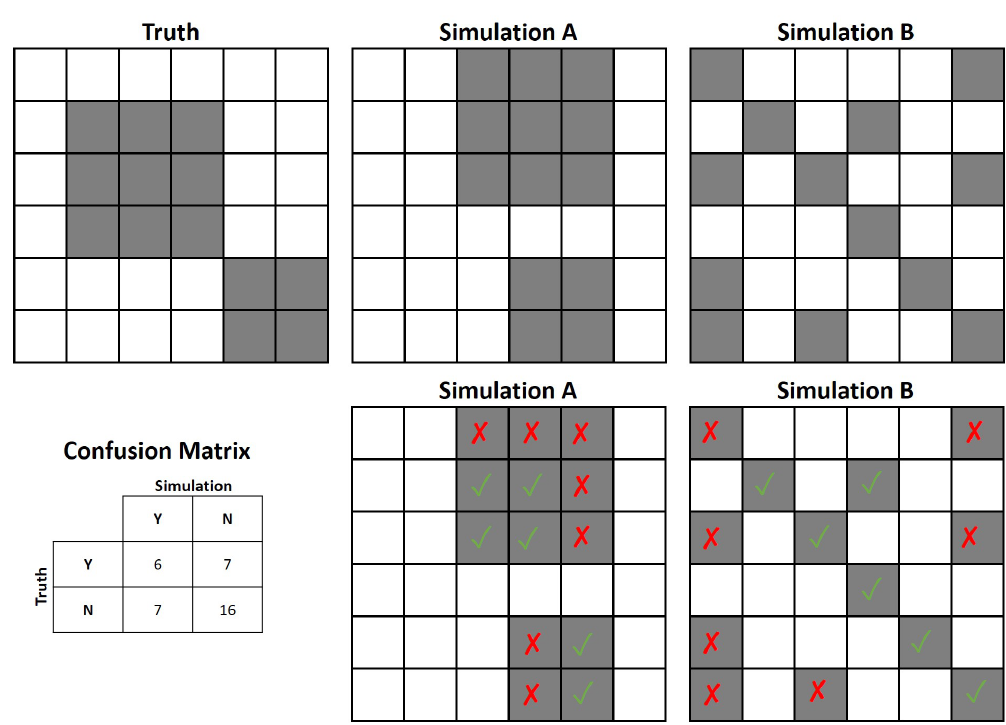
Figure 1. Example of two simulations (A and B) and their comparisons to observed truth. Grey boxes represent changes in a map class. Simulation A and B have an identical confusion matrix, and therefore identical quantity and allocation disagreement (also identical kappa). However, Simulation A has perfect configuration accuracy (i.e., one patch of 9 boxes and another with 4) and Simulation B does not. A systematic review by van Vliet et